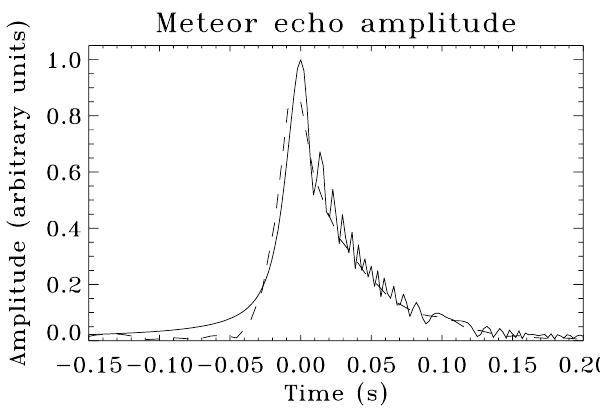
Fig. 4. Meteor echoes obtained for a PRF of 110Hz (solid line) and a PRF of 440Hz with 4 extra coherent integrations (dashed line) us- ing a 31MHz radar sampling an echo with range 150km, meteoroid speed 40kms − 1 , and decay time